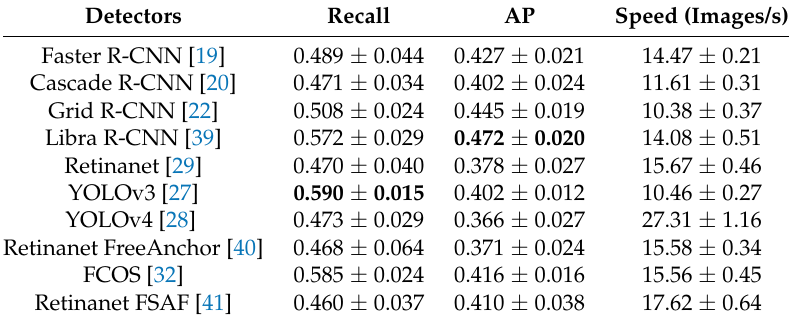
Table 12. Results on the EPD-C subset. Train resolution, 1–2 m/pixel; test resolution, 4 m/pixel. AP refers to average precision. Recall, AP, and speed are expressed in the format of mean ± standard deviation on the basis of 10 rounds of test